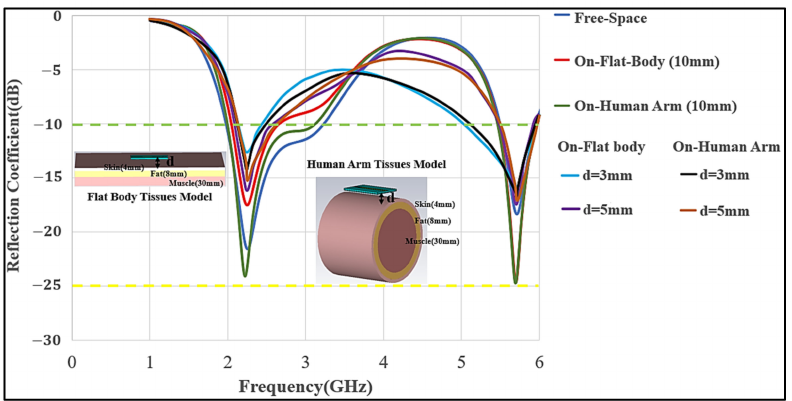
Figure 5. Optimization of S 11 for meander line monopole antennas (MMAs) in free-space, on-chest flat model, and arm model with various locations on the body (3 mm, and 5